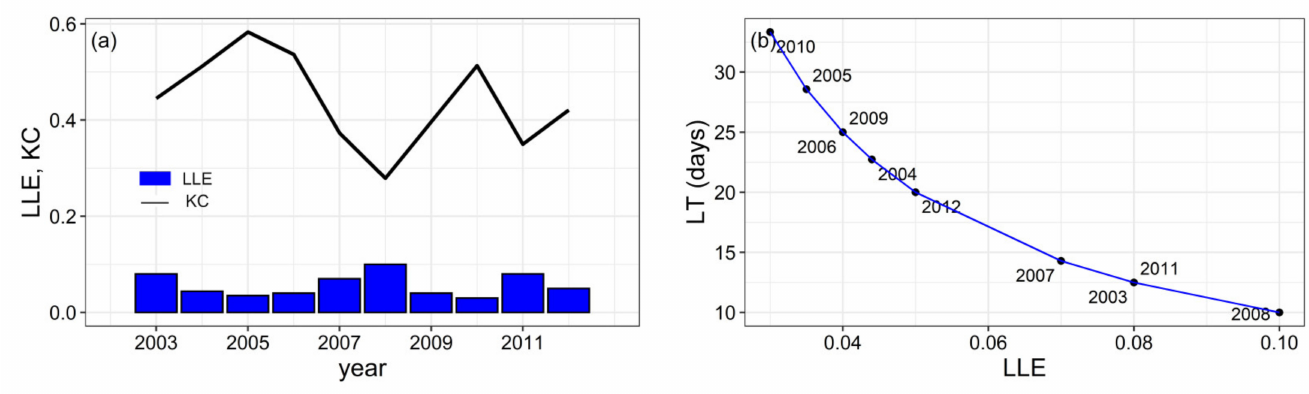
Figure 10. ( a ) Largest Lyapunov exponent (LLE) and Kolmogorov complexity (KC), and ( b ) LLE versus Lyapunov time (LT) of daily H er time-series in Novi Sad.